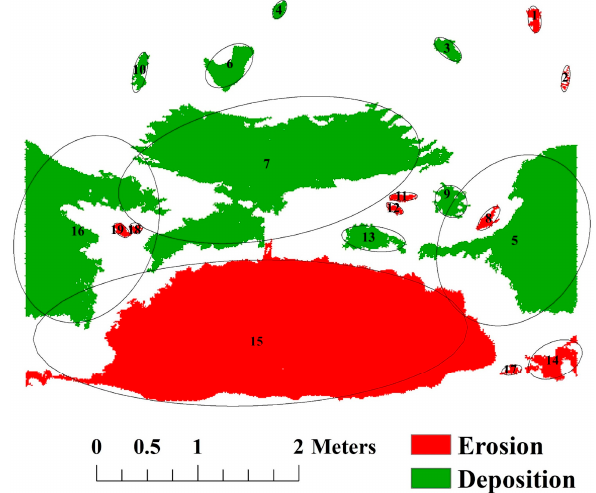
Figure 10. CMA identified nineteen significant erosional and depositional objects highlighted by fitted ellipses. Table 1. Attributes of Objects Identified from CMA Sorted by Object Type and Volume.